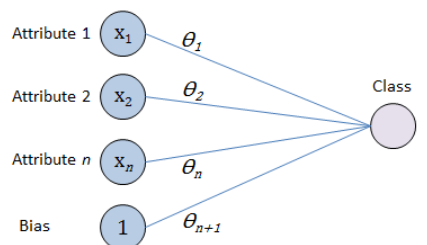
Figure 1. Example of a simple logistic regression model.